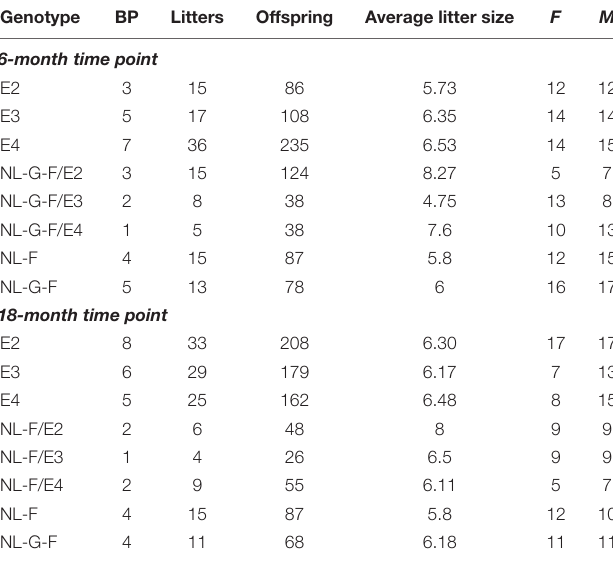
TABLE 1 | Breeding success for generating the mice with the desired genotypes and experimental mice for the 6- and 18-month time points 1 .